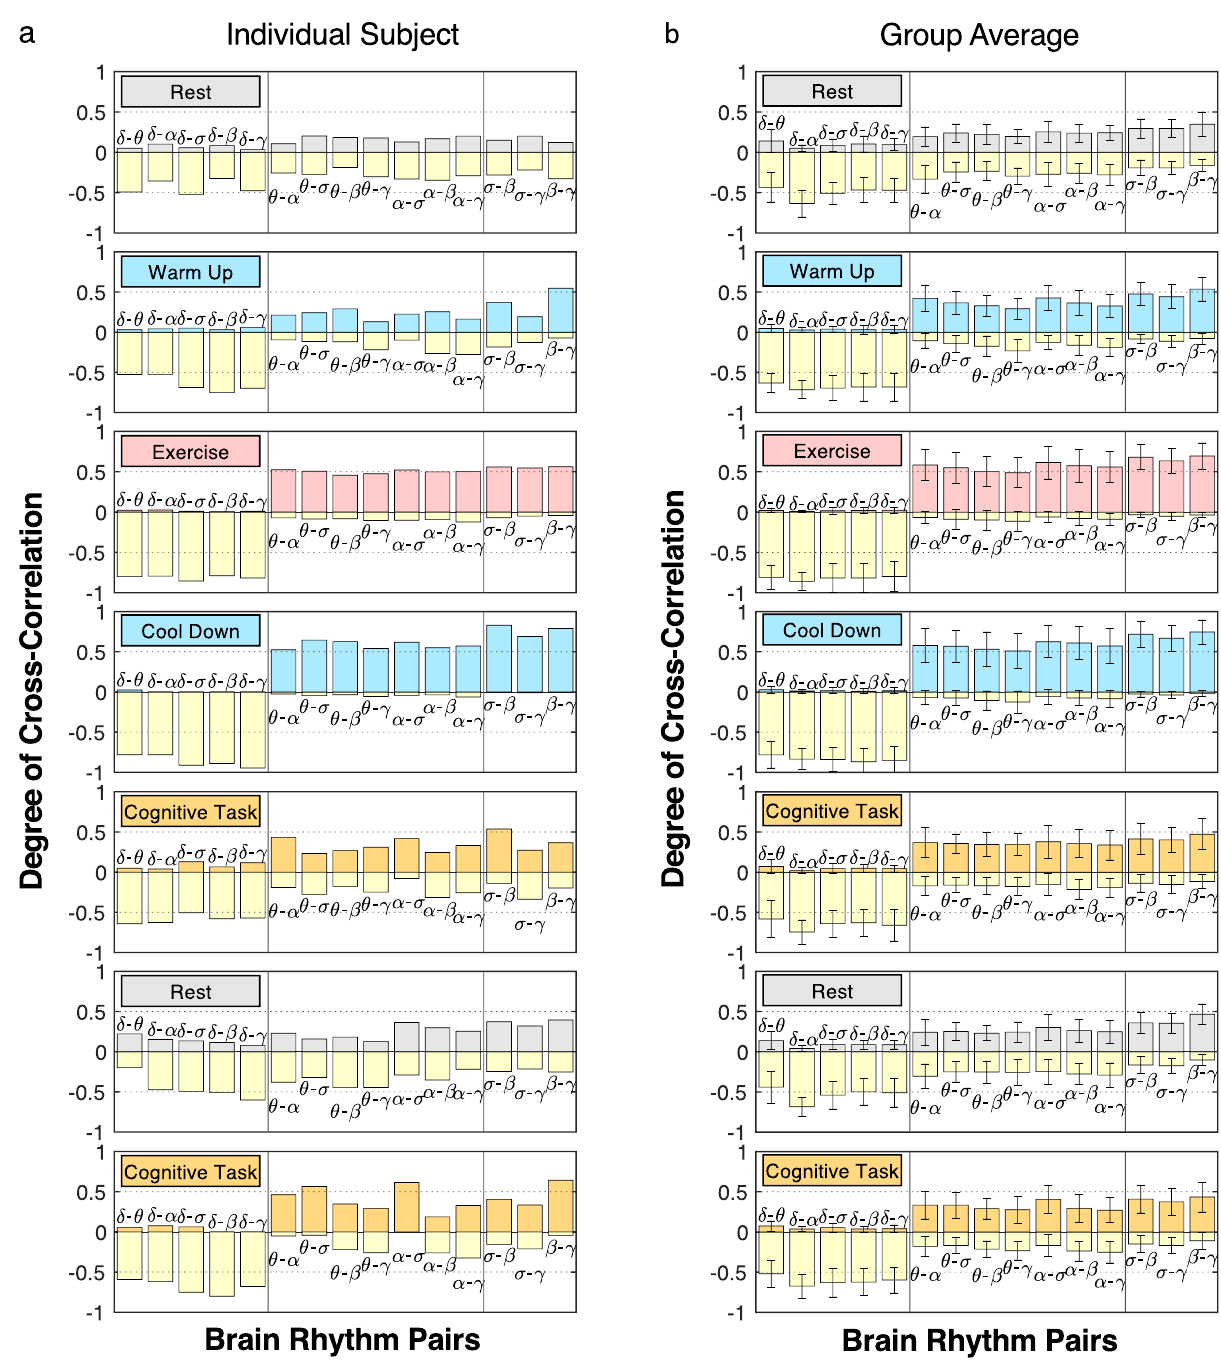
Fig. 3 Robust strati fi cation in the degree of coupling between brain rhythms across physiological states. Bar plots represent coupling strength derived from the cross-correlation distribution pro fi le (Fig. 2) for each pair of brain rhythms at a given physiological state for ( a ) an individual subject and ( b ) the group average represented by pooled data from all subjects (Supplementary Fig. 3). For each pair of brain rhythms, bars height quanti fi es the probability of obtaining signi fi cant cross-correlation ( ∣ C ∣ > 0.5), where positive bars (colors matching states) represent the degree of positive correlation and negative bars (yellow color) represent the degree of anti-correlation (see Methods). Three classes of brain-rhythm interactions are observed across all physiological states: (i) strong anti-correlated interactions for pairs of rhythms δ - θ , δ - α , δ - σ , δ - β , δ - γ ; (ii) strong positively correlated interactions for σ - β , σ - γ , β - γ ; (iii) mixed cross-correlations for θ - α , θ - σ , θ - β , θ - γ , α - σ , α - β , α - γ , with a high degree of positive coupling during warm-up, exercise and cool-down, and more expressed negative (anti-correlated) coupling during cognitive task and rest. With transitions across physiological states, a clear strati fi cation pattern in the degree of coupling between brain rhythms is consistently observed for all subjects in the database. Error bars in ( b ) represent group standard deviation. Such robust strati fi cation in coupling strength based on physiological states reveals a universal complex organization of interactions among brain rhythms across